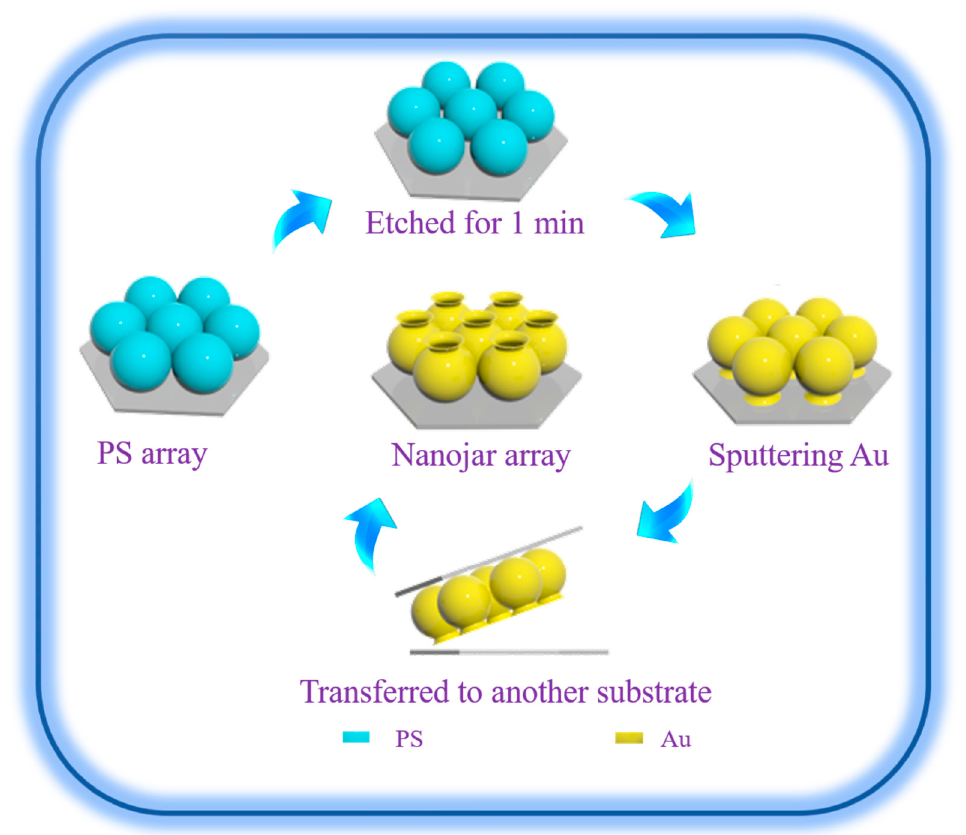
Figure 1. Schematic of the fabrication process for nanojar arrays.